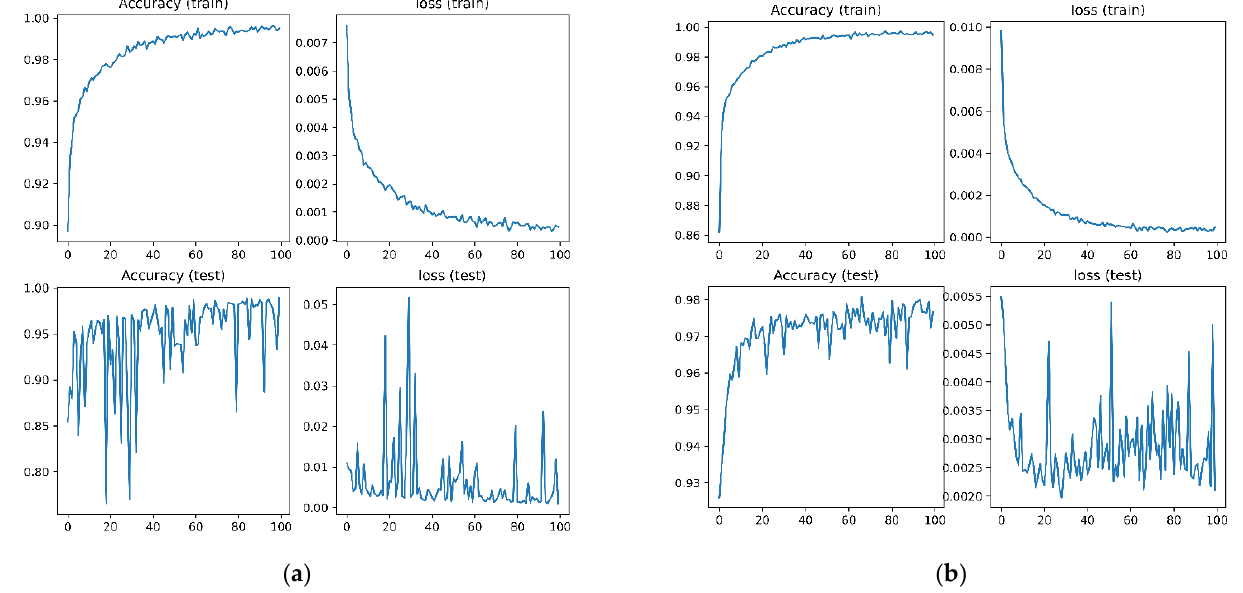
Figure 14. Training process of lightweight model: ( a ) model of this work, ( b ) optimization of model of this work.